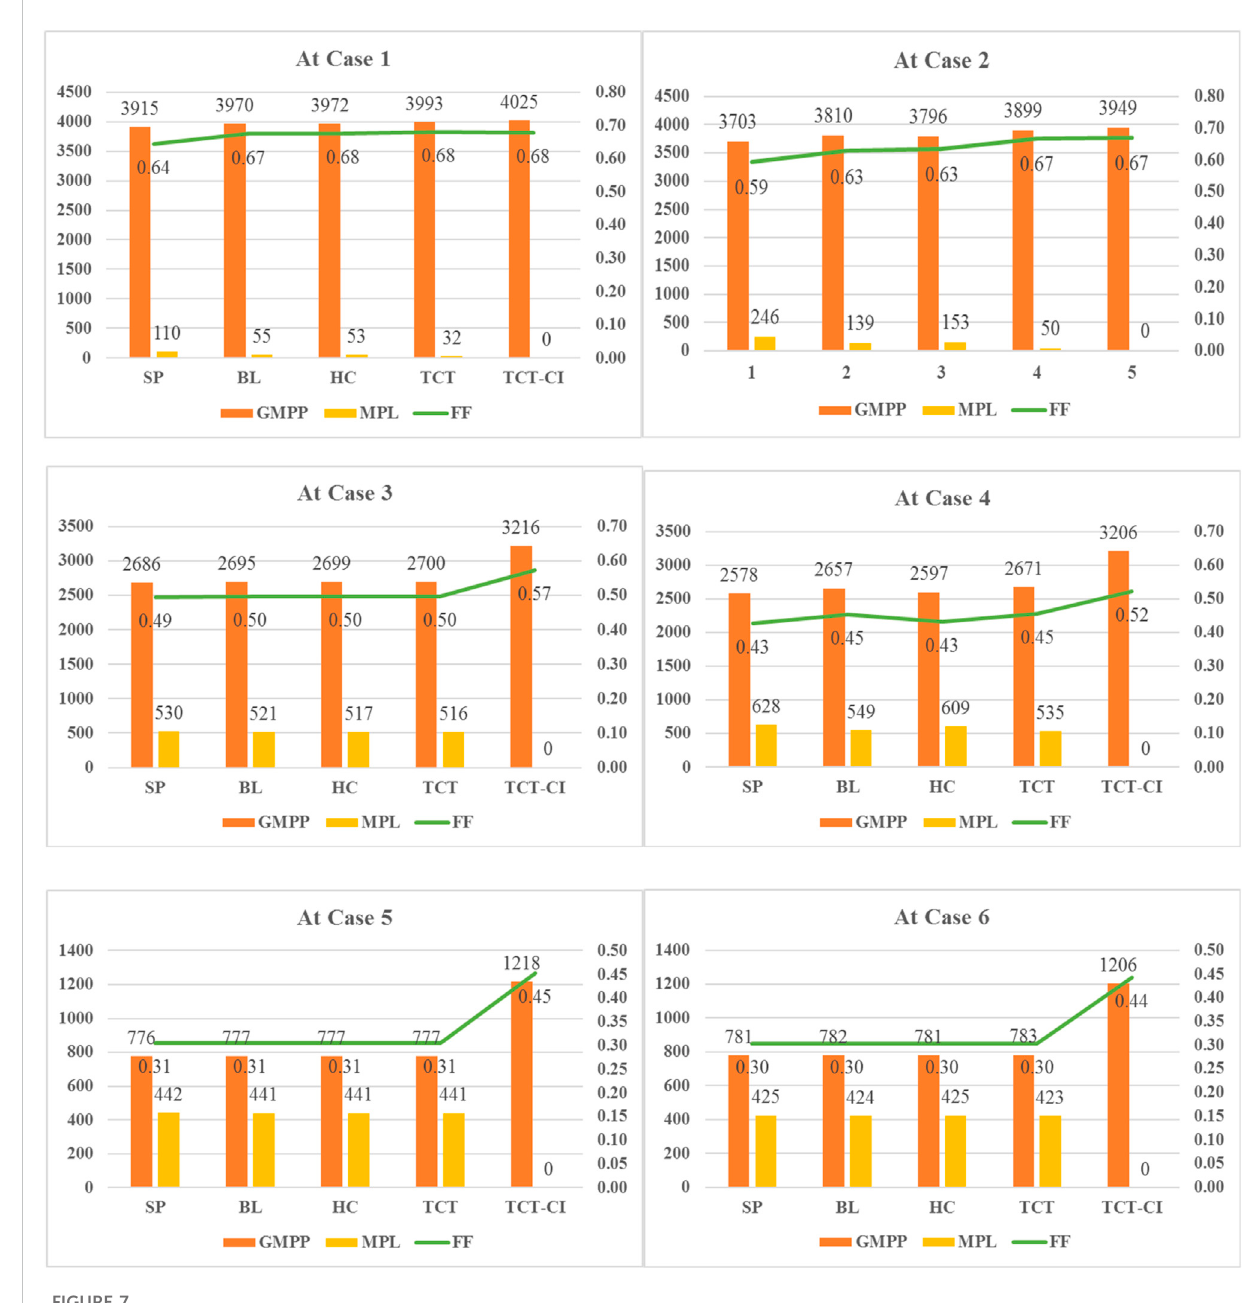
FIGURE 7 GMPP, MPL, and